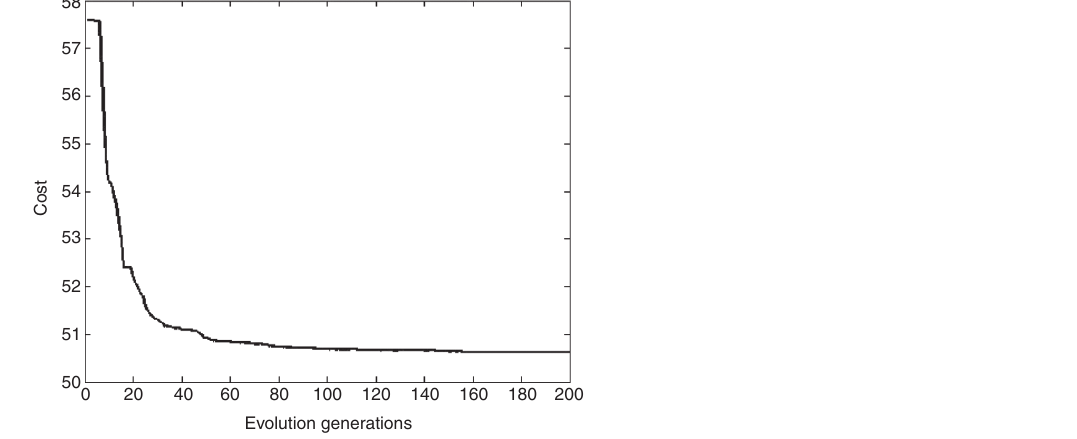
Figure 5. Convergence Curves.